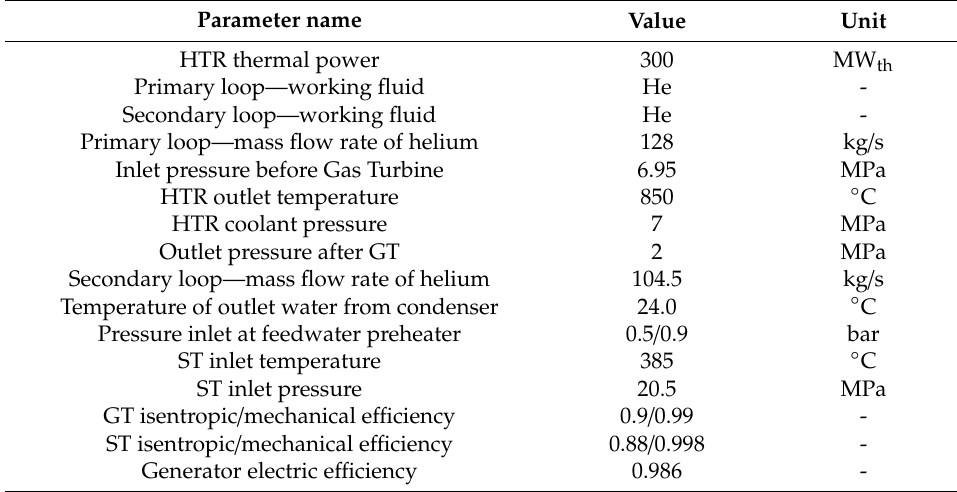
Table 5. Working parameters and assumptions for thermodynamic